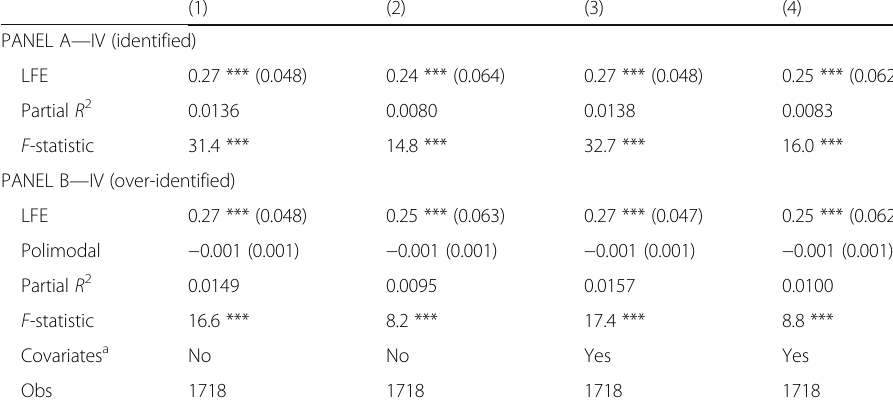
Table 6 The effect of educational reform on years of schooling. 2SLS estimates — first stage (Eq.